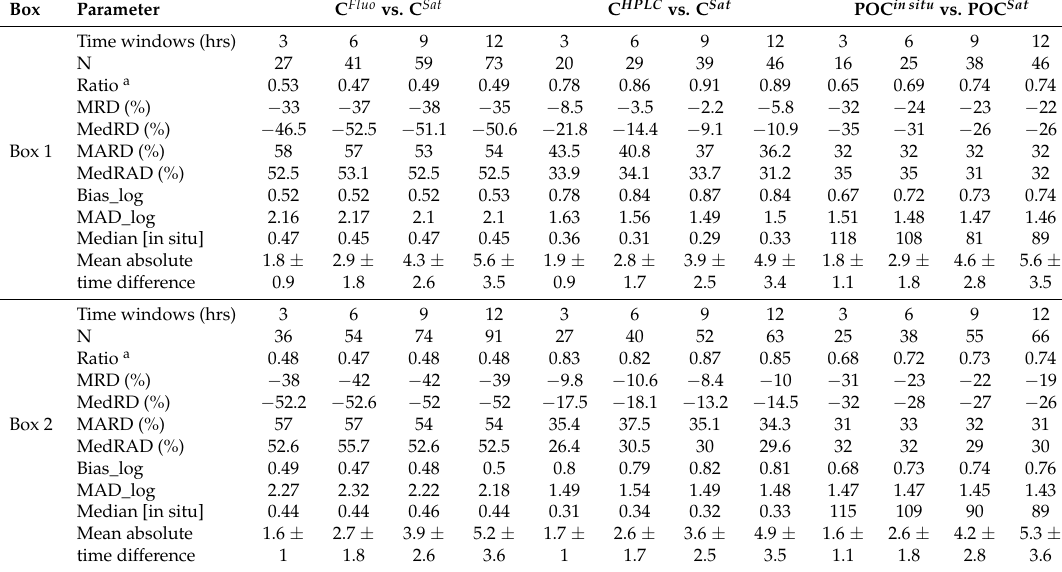
Table 2. Statistics of the comparison between satellite and in situ values of chlorophyll-a (mg m − 3 ) and POC (mg m − 3 ) with chlorophyll-a measured from fluorometry (C Fluo ) and HPLC (C HPLC ) and POC dry-blank-corrected (POC insitu ), for different time windows and two spatial binning methods: a box of 5 by 5 pixel around the in situ location (box 1), and, all pixels in a radius of 8 km around the station (box